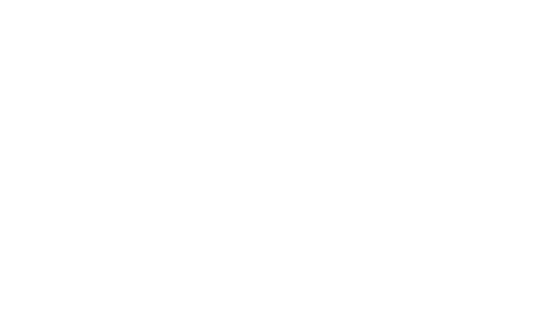
Table 2. Comparison of Mendelian error rates of variants from the two different